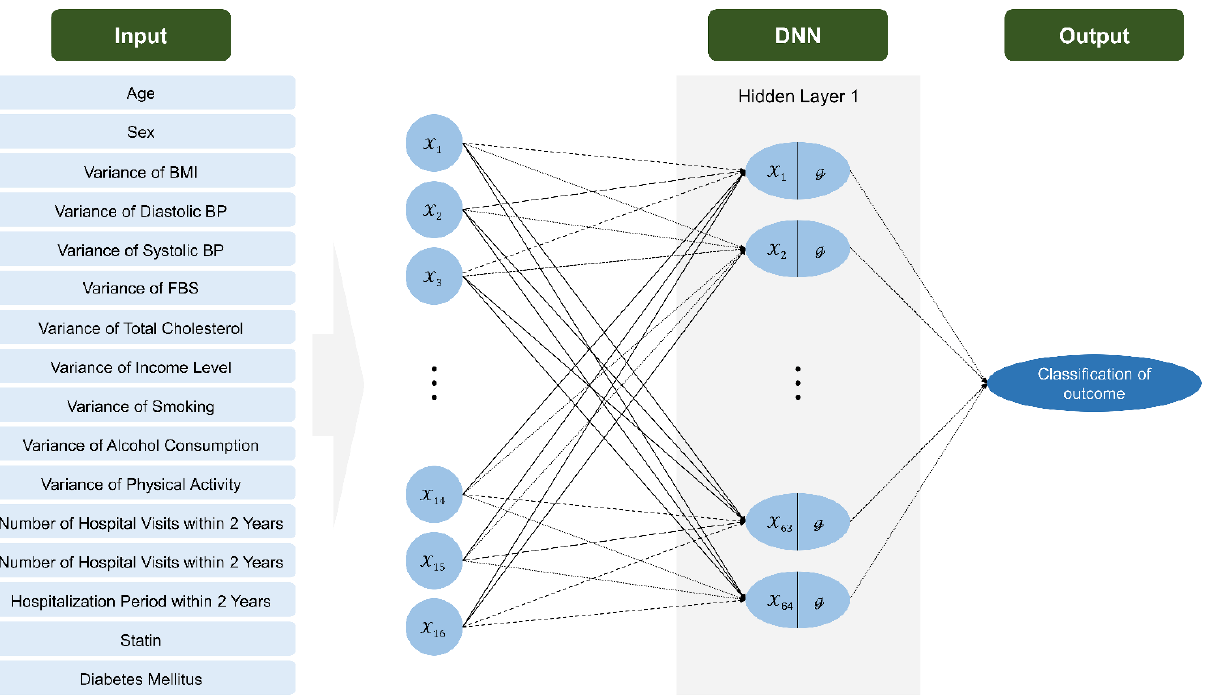
Figure 2. The structure of DNN model for outcome classification. Circles represent neurons. The arrows indicate heavy-weight transmissions between neurons and dashed arrows indicate the invalid neuronal connection. BMI: body mass index. BP: blood pressure. DNN: deep neural network.